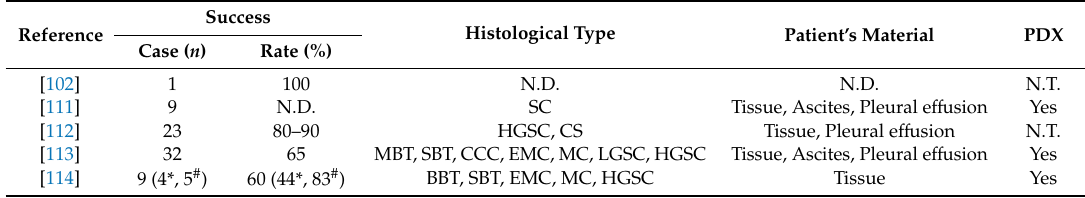
Table 1. List of studies on primary organoid culture of ovarian